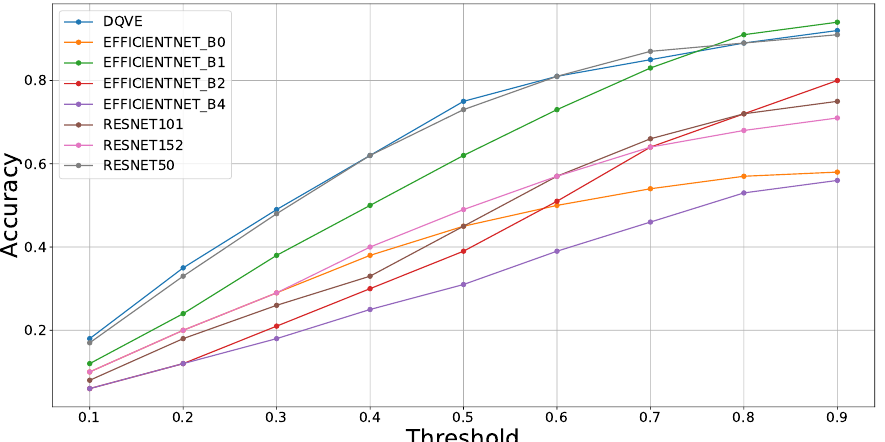
Figure 7. Classification accuracy of the proposed DQVENet and other compared methods under different